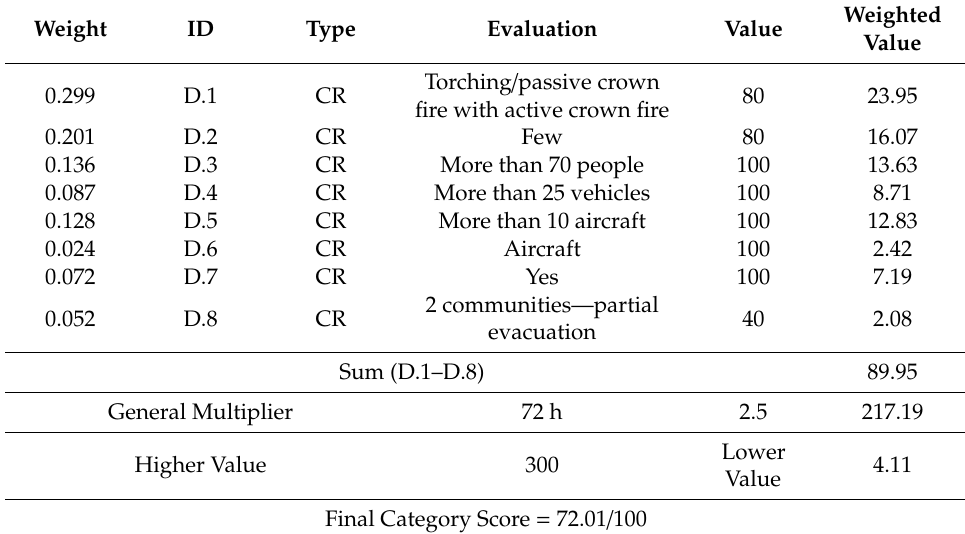
Table A18. Evaluation table of firefighting and wildfire suppression activities for the Evros fire. CR: criterion. Original matching Table A4.